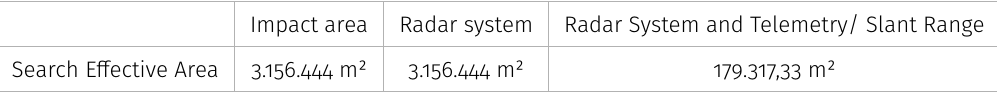
Table I. Comparison between systems radar and Telemetry Antenna Fusion/ Slant